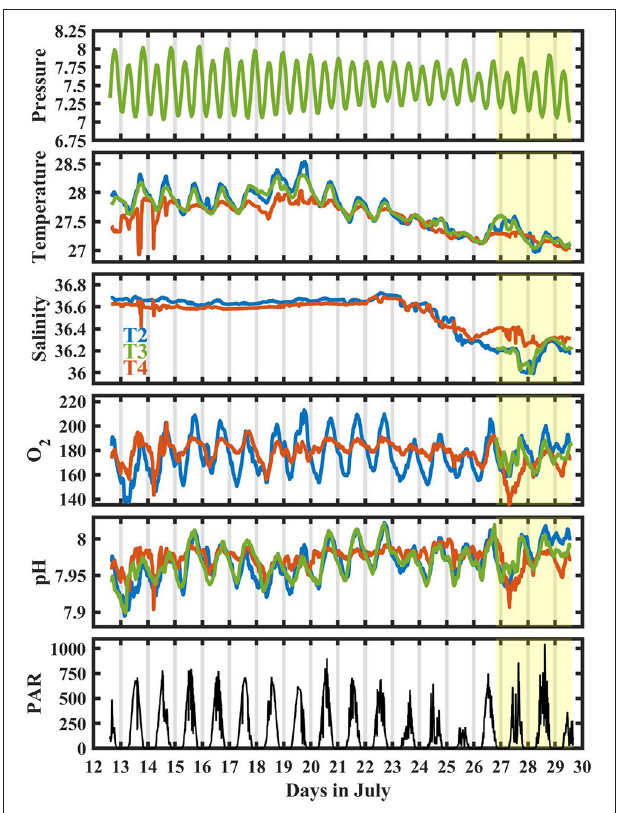
FIGURE 2 | Time series at T2 (blue), T3 (green), and T4 (red) for pressure [dBar], temperature [Celsius], salinity, O 2 [ µ mol kg − 1 ], pH [total scale], and PAR at 11m at T3 [ µ mol photons m − 2 s − 1 ]. Only pressure at T3 is shown for clarity. Shaded yellow represents when BEAMS was deployed.